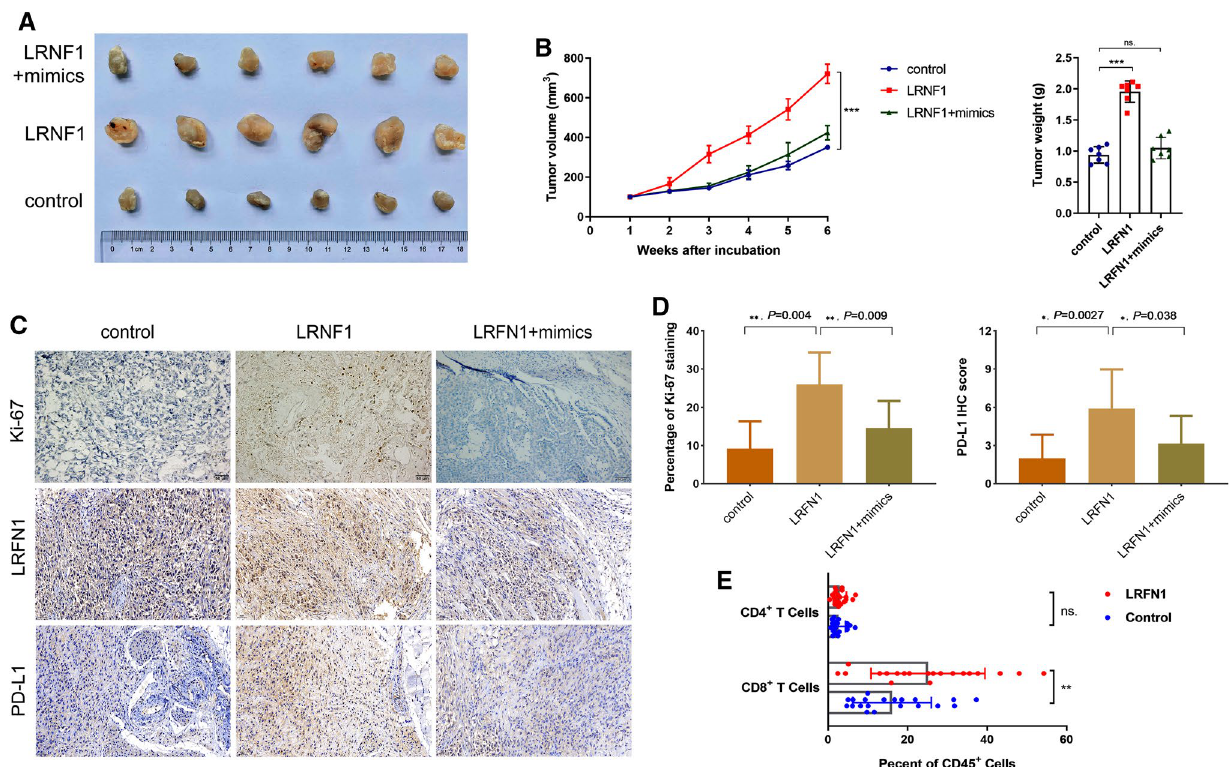
Fig. 6 LRFN1 promotes ccRCC growth and immune-infiltrating TIME on a xenograft model. A The representative images of three groups (control, LRFN1 overexpression plasmid, LRFN1 plus miR-187-3p mimics) on the xenograft model. B miR-187-3p rescues LRFN1 promoted A498 cell volume and weight in vivo. C , D The IHC staining was performed to assess Ki-67 staining, LRFN1 expression and PD-L1 expression of three groups. E The Flow cytometry assay was performed to reveal active CD4 + and CD8 + T cells in tumor tissues between high and low LRFN1 expression groups. * P < 0.05; ** P < 0.01; *** P <